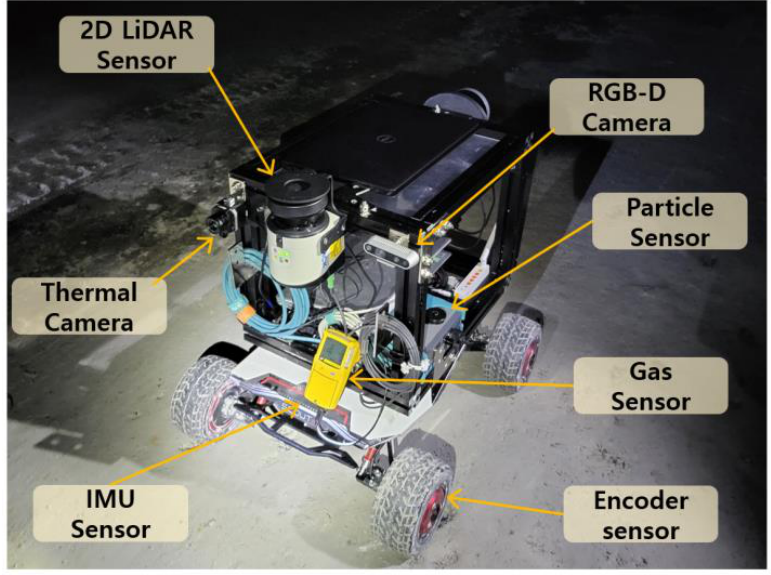
combined to improve accuracy.